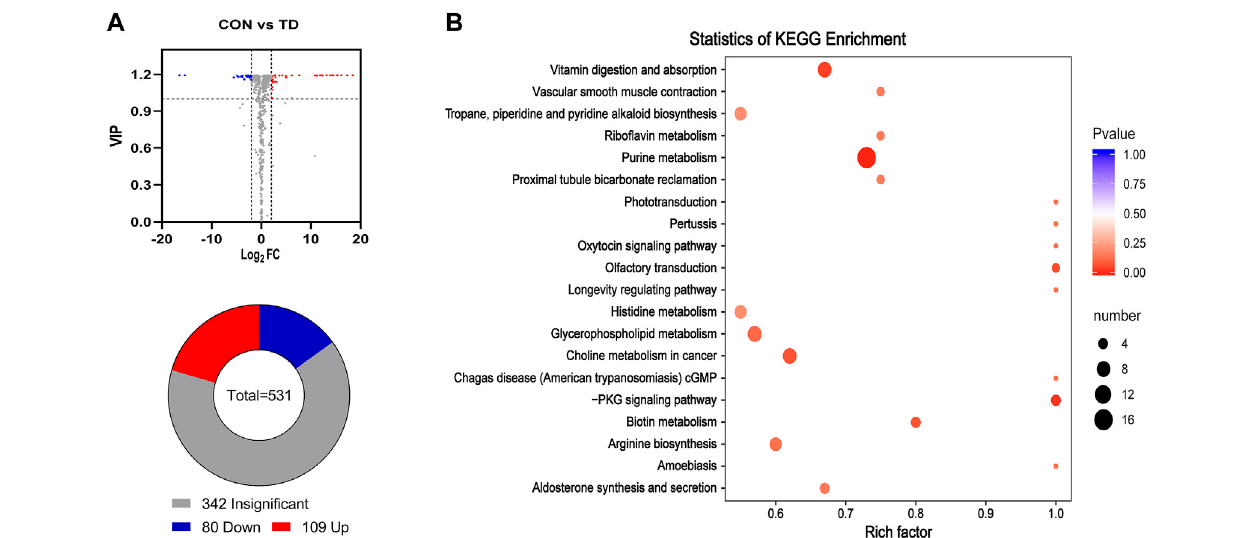
FIGURE 5 | Differential metabolites in feces of broiler chickens with TD. (A) Volcano plot analysis of fecal metabolites. Some signi fi cantly differential metabolites wereselectedoutbyusingthecriteriaofFC S 2orFC & 0.5andVIP S 1inthevolcanoplot.Signi fi cantlydifferentialmetaboliteswereshownasared(up) orblue(down) dot, whereas a gray dot represented non-signi fi cant difference of metabolites. The number of differential metabolites is shown using a pie chart. (B) Potential metabolic pathwaysanalysisbased on signi fi cantly differential metabolites in feces from the CON and TD group chickens. The bubble size indicates the number of signi fi cant differential metabolites enriched in this pathway, and the point with the different gradation of color (from red to blue) represents the scope of p -value. The bigger size of each circle indicates a higher degree of enrichment, and the lower p -value represents a more signi fi cant degree of enrichment.